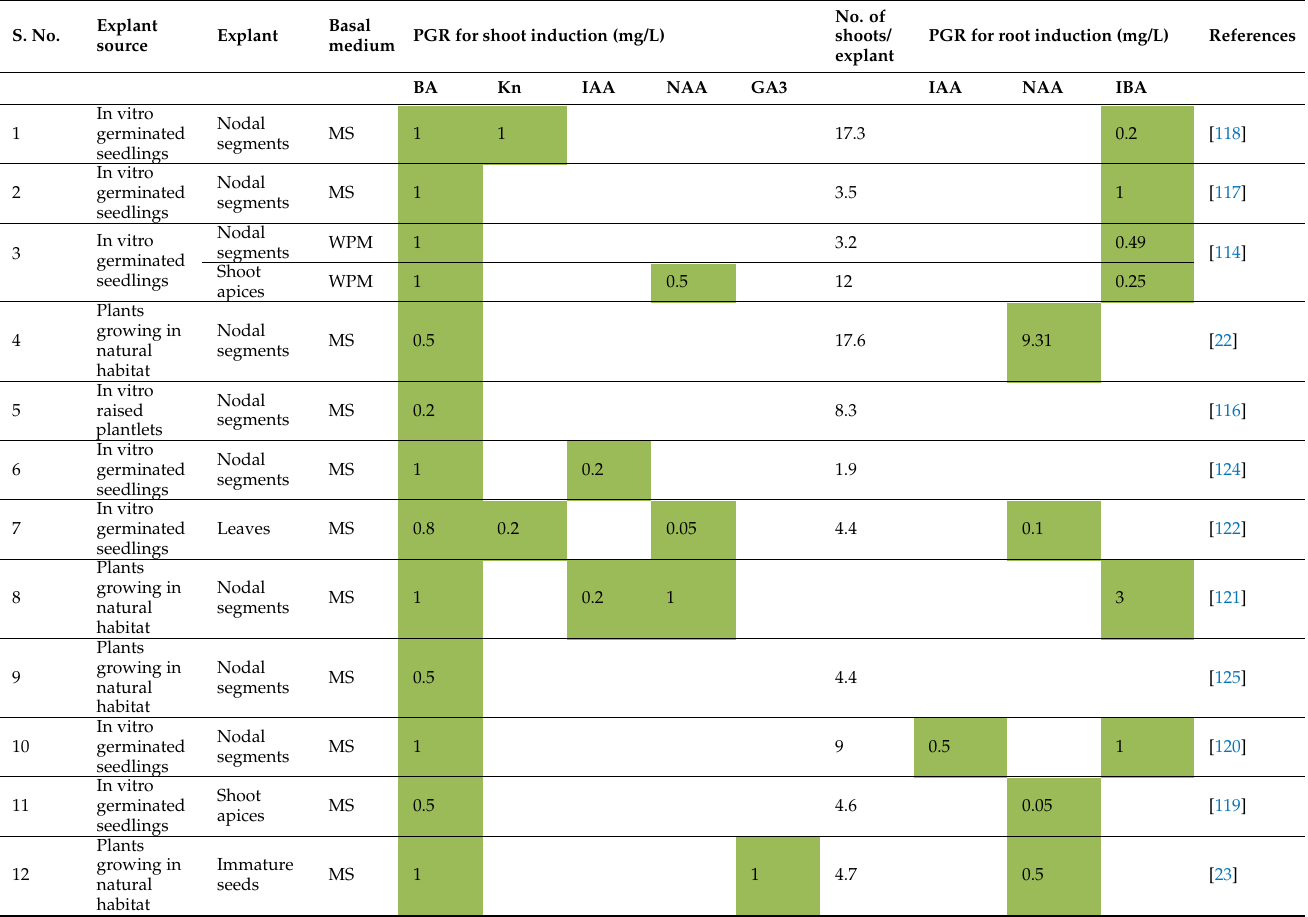
Table 3. Snapshot of different studies on in vitro propagation of